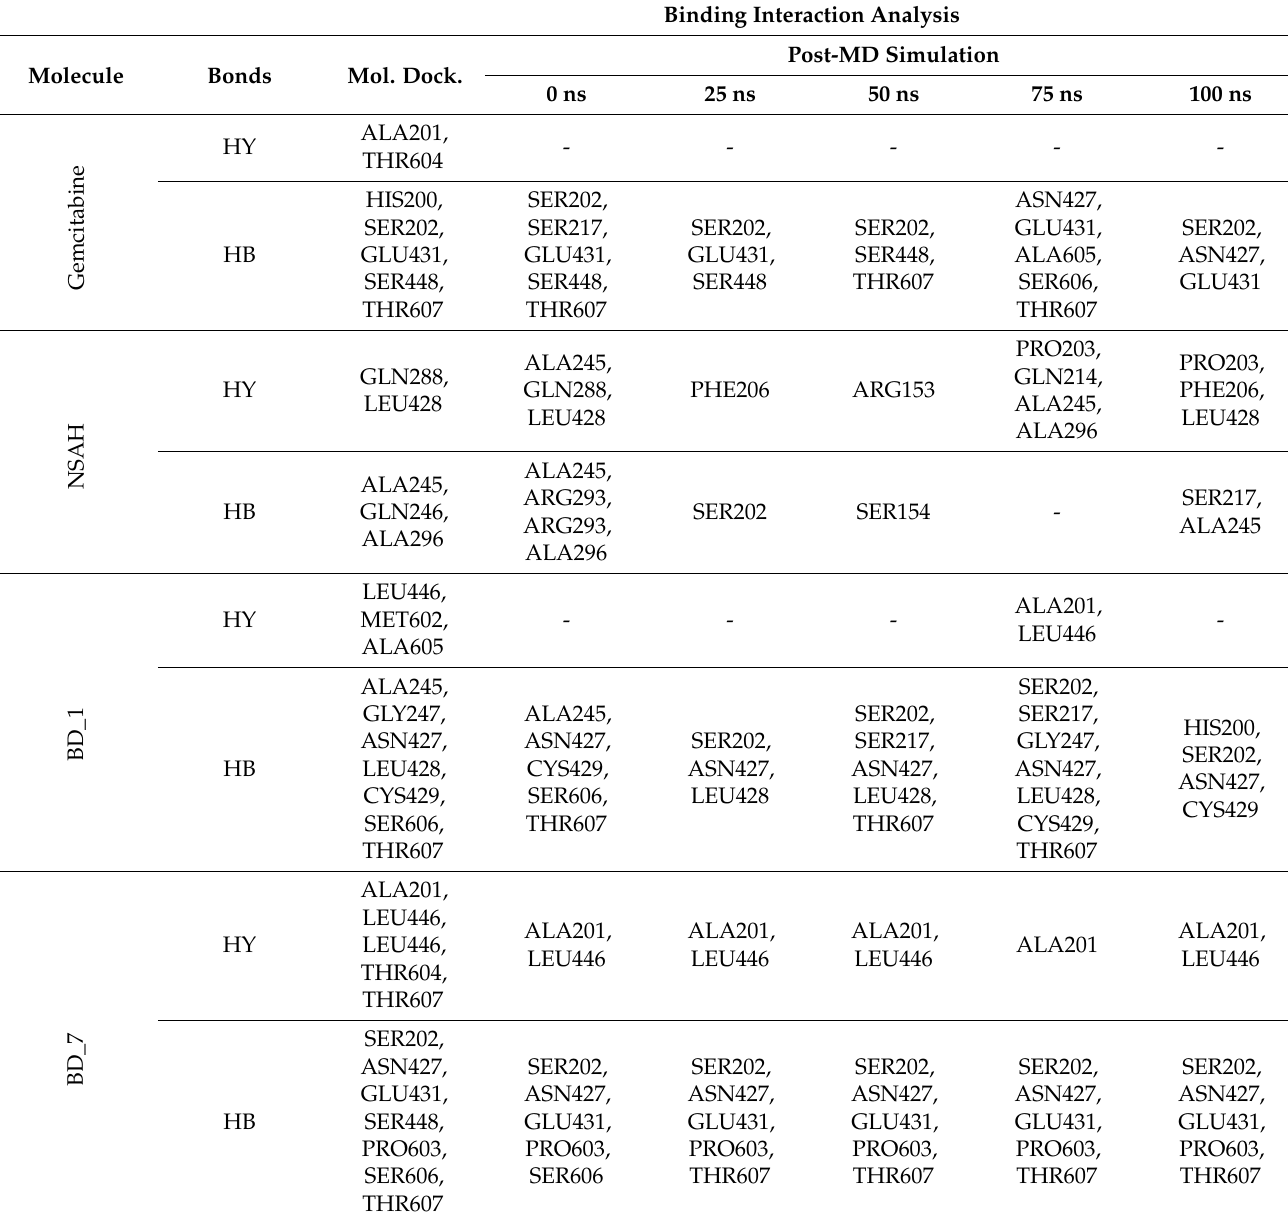
Table 7. Post-MD simulation binding interaction profile at 0, 25, 50, 75, and 100 ns. Binding Interaction